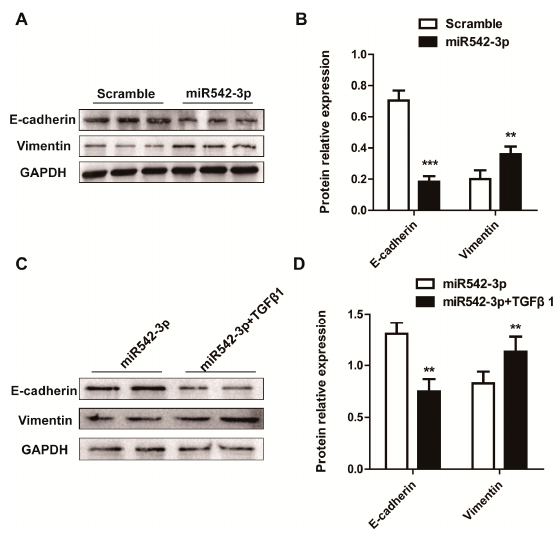
Figure 3. MiR542-3p promotes Epithelial-Mesenchymal Transition (EMT) ( A ) Western blot results showed the expression levels of E-cadherin and Vimentin in NRK52e cells induced by 50 nM control mimics or miR542-3p; ( B ) Histogram showed the gray scale quantitative analysis for Western blot results; ( C ) Western blot results showed the expression levels of E-cadherin and Vimentin in NRK52e cells induced by 50 nM miR542-3p with or without 2.0 ng/mL TGF β 1; ( D ) Histogram showed the gray scale quantitative analysis for Western blot results. All data are displayed as means ± SD from three independent experiments, ** p < 0.01, *** p < 0.001. Int. J. Mol. Sci. 2015 , 16 , page–page